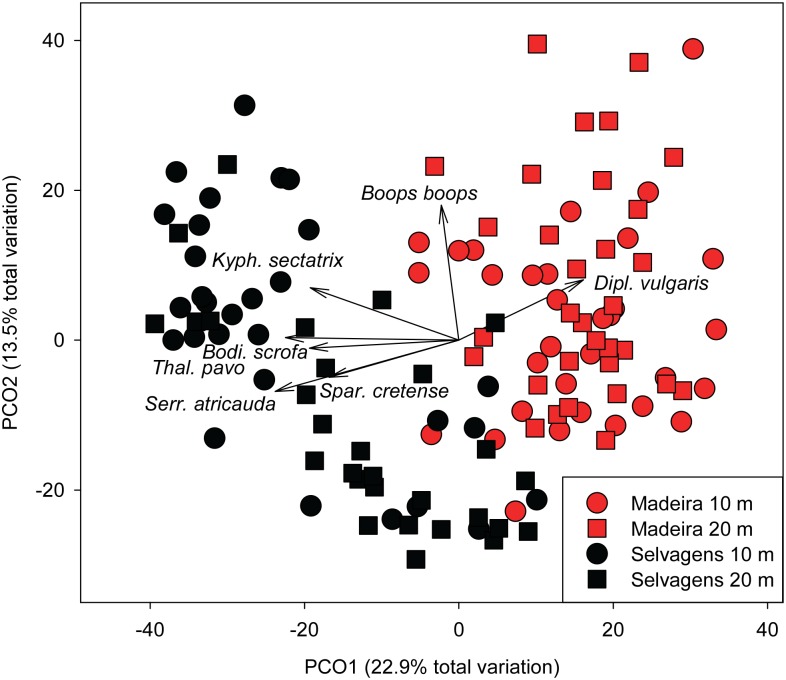
Principal Coordinates Analysis of fish species biomass.Square root transformation. Bray Curtis Similarity matrix.